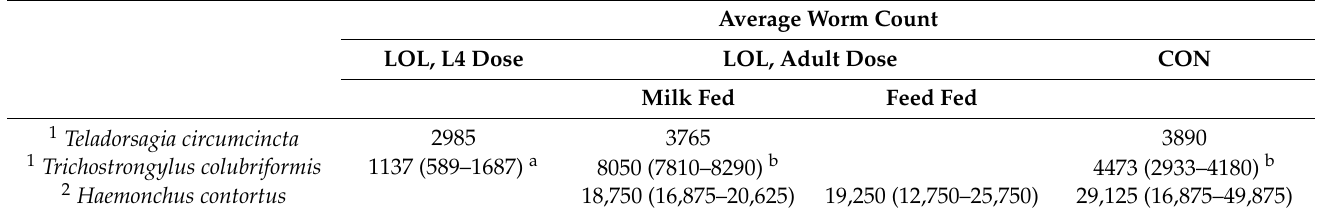
a,b Means within rows with unlike superscripts differ, p < 0.05.